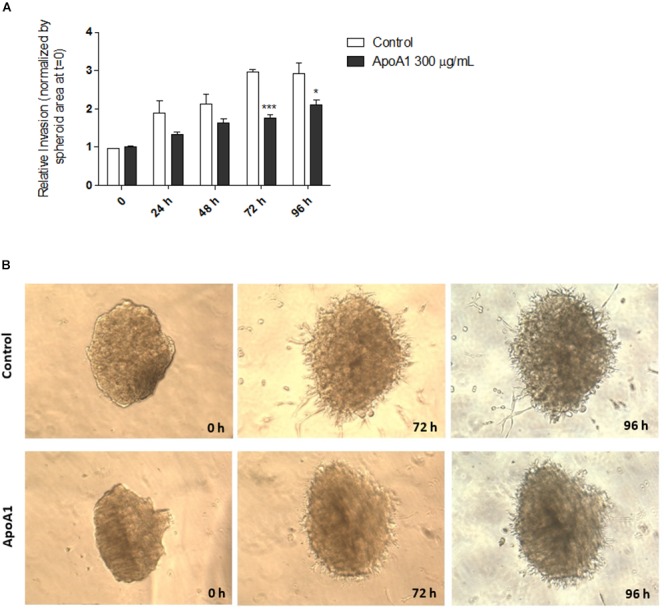
ApoA1 decreases the ability of ovarian cancer cells to invade the extracellular matrix. The 3D tumor spheroid invasion assay was performed in SKOV3 spheroids exposed to ApoA1 at a concentration of 300 μg/mL, and in unexposed spheroids (control). Invasion of extracellular matrix was assessed for up to 96 h. Exposure to ApoA1 significantly decreased the ability of SKOV3 cells to invade the extracellular matrix after 72 h (Two-way ANOVA; p < 0.001) and 96 h (p < 0.05). In (A), the relative invasion normalized to the spheroid area at time = 0 is plotted for ApoA1-treated and untreated spheroids. In (B), it is shown two spheroids, representatives of the ApoA1-treated and control conditions, at the beginning of the experiment (time = 0) and during the course of experiment (72 and 96 h). Differences were considered significant if p < 0.05. ∗p < 0.05, ∗∗∗p < 0.001.